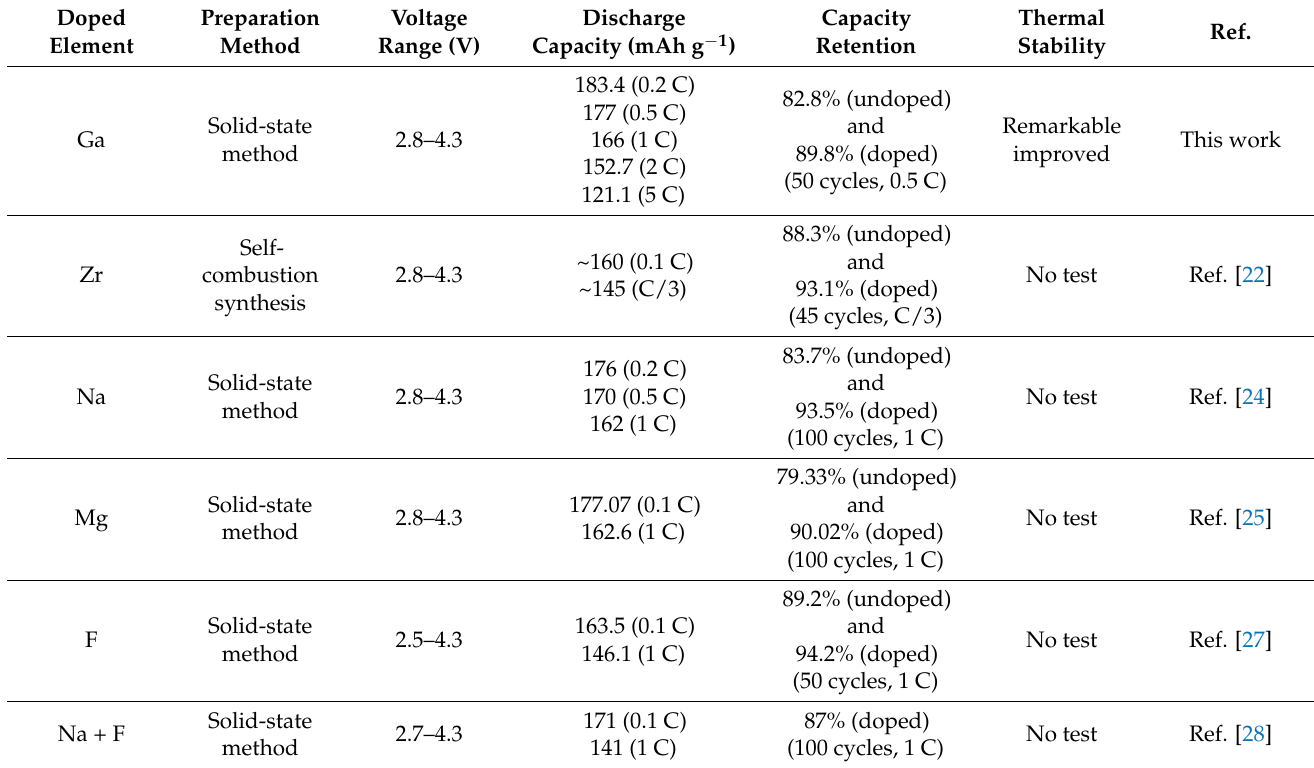
Table 2. Comparison of electrochemical performance of doped LiNi 0.6 Co 0.2 Mn 0.2 O 2 materials from different